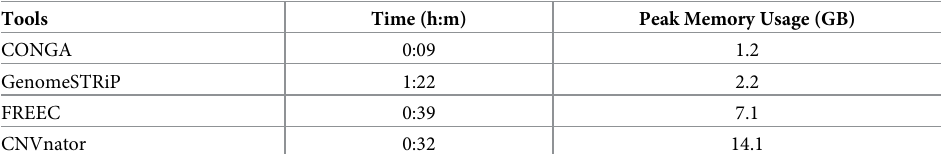
Table 1. Time and memory